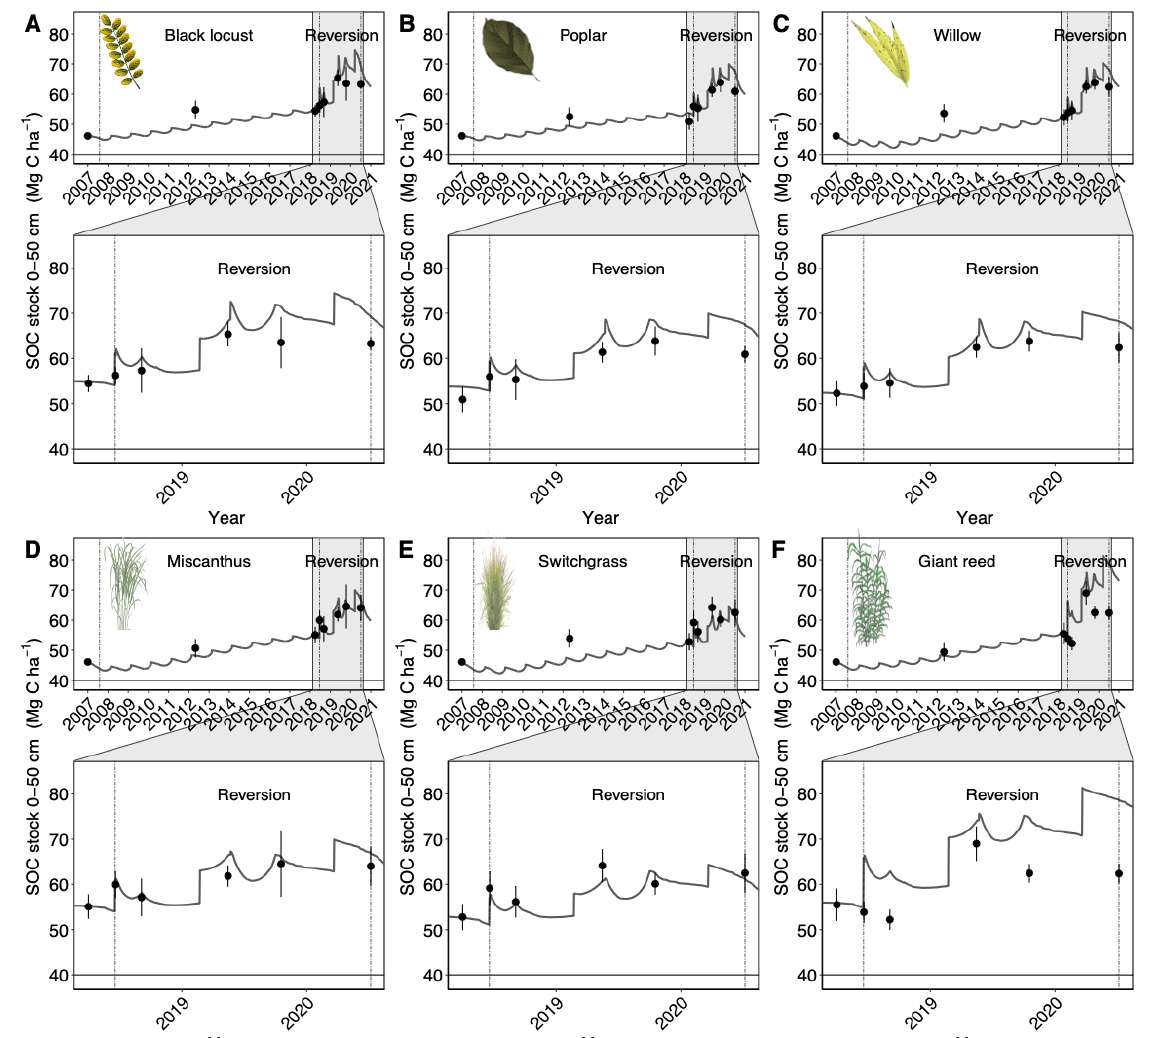
Figure 2. Results of the 13-year (2007 – 2020) ECOSSE simulation of soil organic carbon (SOC) under six different perennial biomass crops (2007 – 2018) and their reversion to annual crops (2018 – 2020) on a former marginal arable land. A focus on the reversion is shown for each crop: ( A ) Black locust, ( B ) poplar, ( C ) willow, ( D ) miscanthus, ( E ) switchgrass, and ( F ) giant reed. Mean SOC from soil cores obtained at different times between 2007 and 2020 are shown with error bars indicating the 95% confidence intervals. Table 2. Percentage over total C emission and average daily rate (kg C ha −1 day −1 ) of C emission as calculated from ECOSSE simulations for each annual crop cultivated after the reversion of perennial biomass crops.